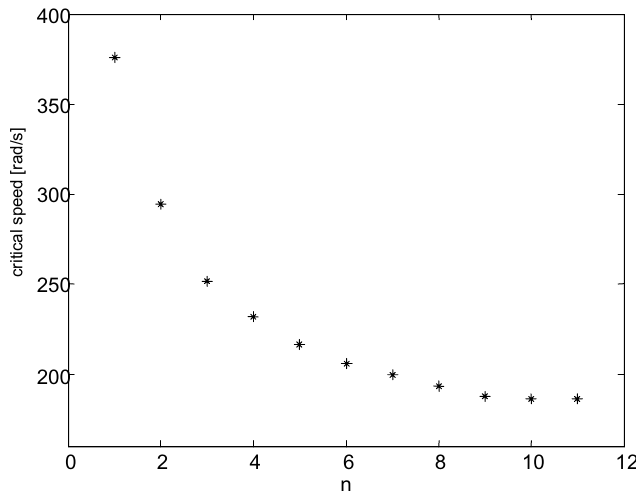
Fig. 10. Critical speed diagram obtained using the first 11 natural frequencies that are associated with cross-section propagation mode m = 2.